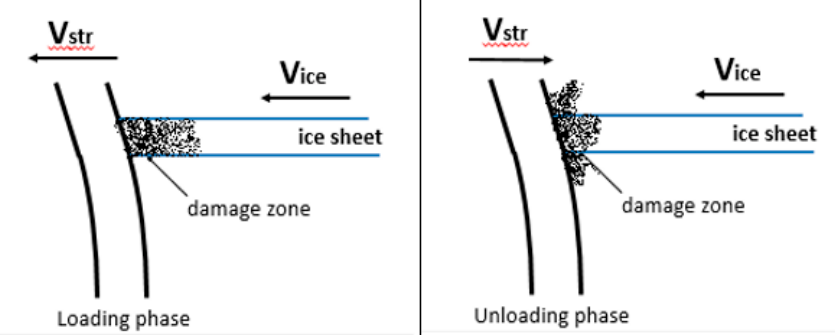
Figure 13. Ice-induced self-excited vibration physical mechanism.